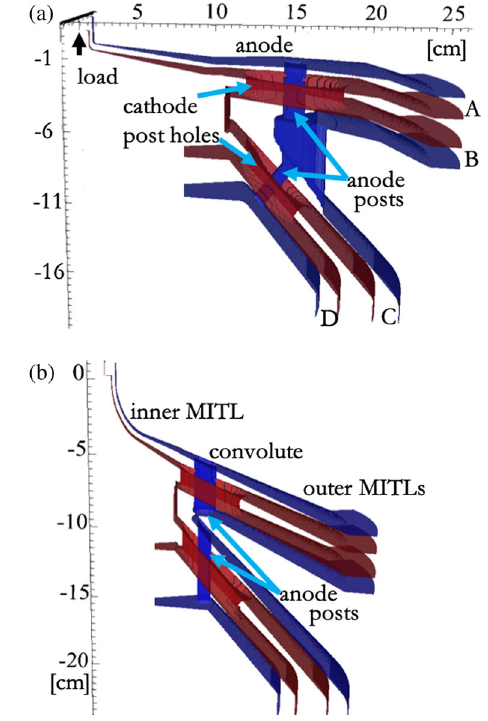
FIG. 3. Illustration of the outer MITLs, double post-hole convolute, and inner MITL fielded for (a) a ∅ 31 cm convolute and (b) a ∅ 15 cm convolute. A pulse-generating circuit is attached at the four outer MITL feeds labeled A, B, C, and